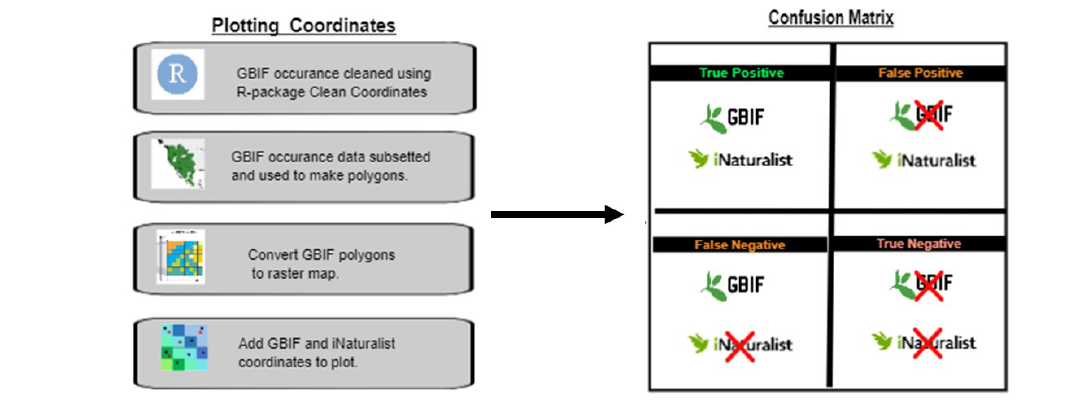
Figure 4. Geo-tagging Workflow. Plotting Coordinates: GBIF occurrence records was cleaned using the R- package, Clean Coordinates. Comparisons of occurrence records (including latitudes and longitudes) for iNaturalist observations were made using the family-level of identification, the genus-level of identification, and the species-level of identification. For each taxon rank, occurrence data was obtained from the Global Biodiversity Information Facility (GBIF) for the order Araneae and subsetted in Rstudio by taxon rank. The subsetted occurrence records were used to create polygon maps, that were then converted to raster maps. GBIF and iNaturalist occurrence records were added to the cells of the raster map. A confusion matrix was used to calculate the accuracy and precision of the iNaturalist occurrence